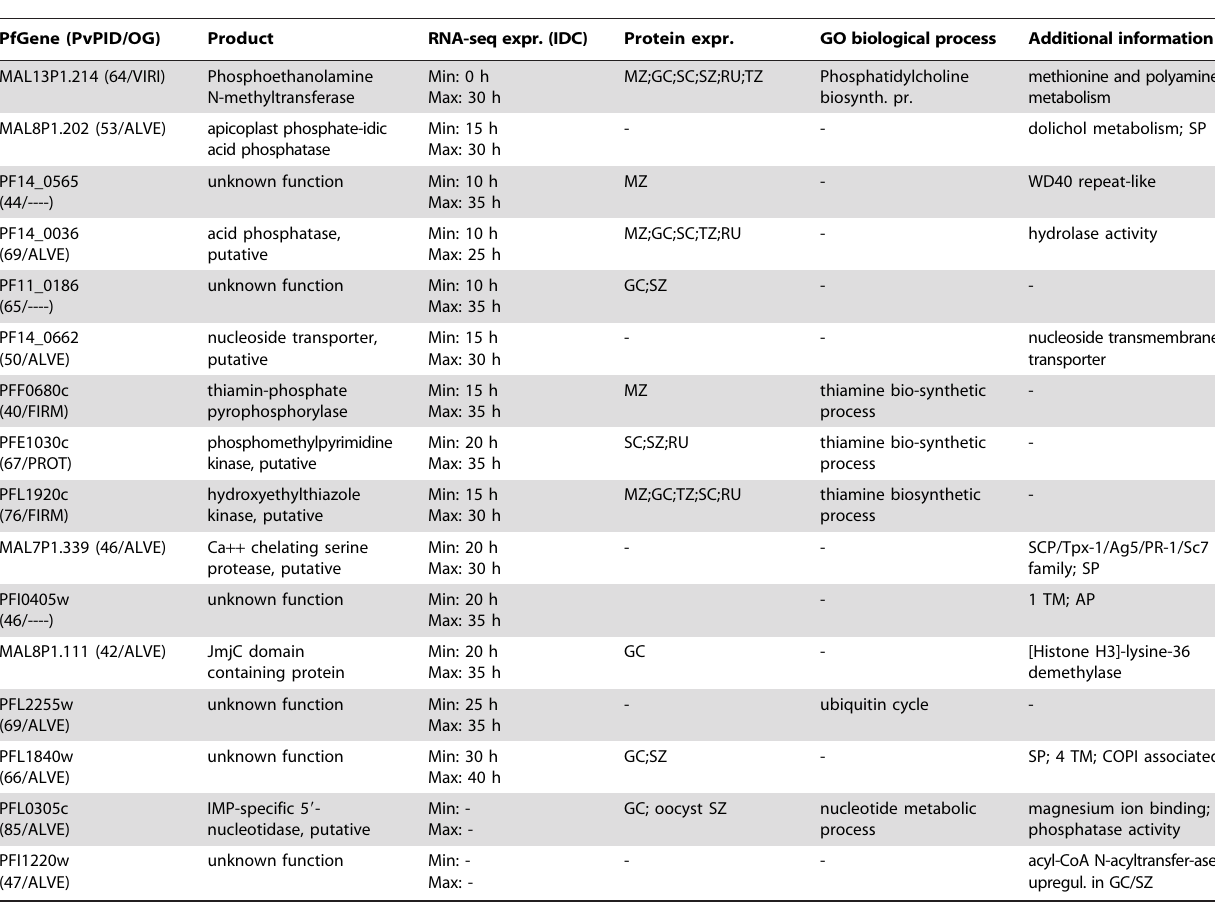
Table 1. Genes conserved in primate parasites but absent in rodent parasites.